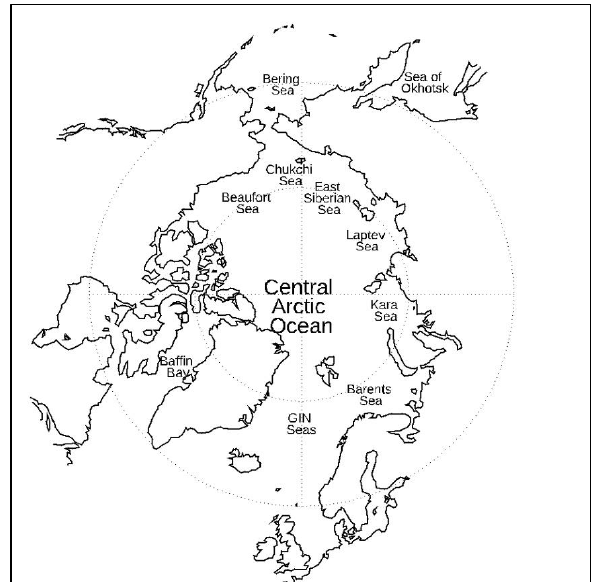
Figure 2. Regional division of the Arctic north of 60 ◦ N, referring to the definition of regional seas in the Arctic from the National Snow and Ice Data Center at https: // nsidc.org / arcticseaicenews / map-of- the-arctic-ocean /